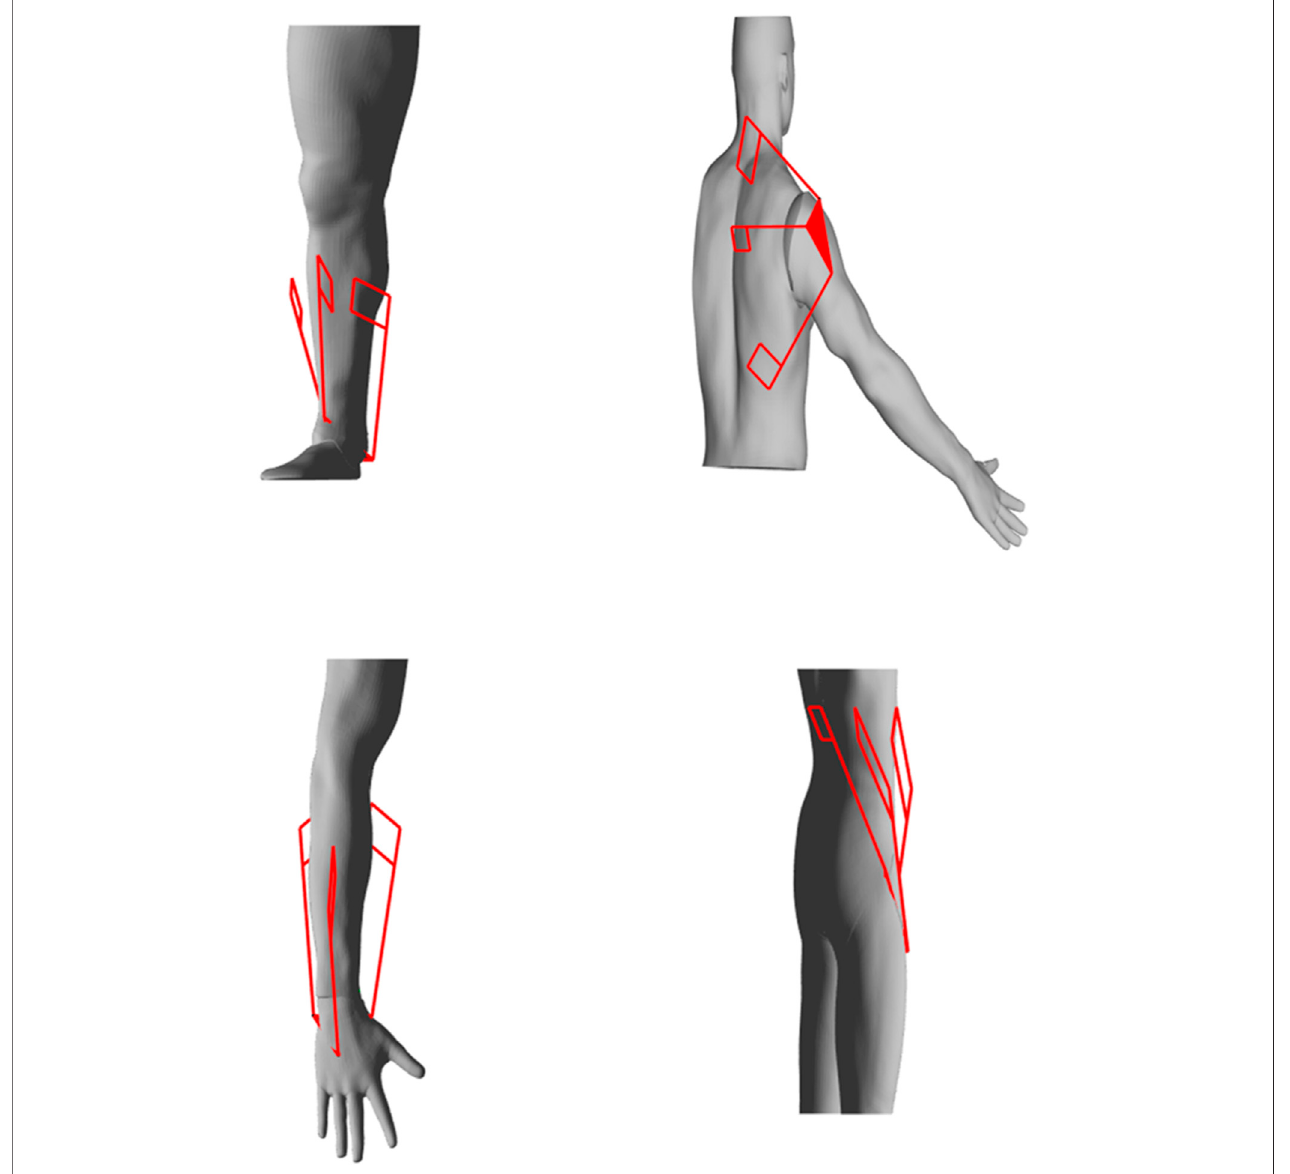
FIGURE 2 | Four embodiments of the 4B-SPM architecture for which the authors have solved the kinematics for include: ankle, shoulder, wrist and hip exoskeletons (Hunt et al., 2017).